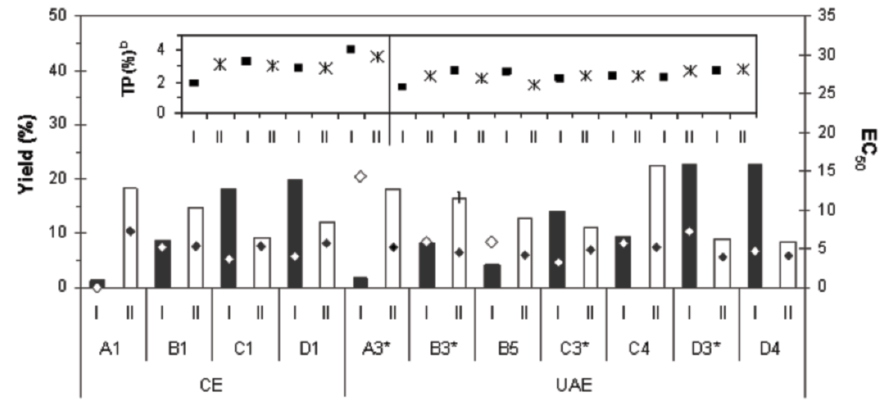
Figure 5. Effect of sonication on the yield and properties of ws-polysaccharides of wheat bran. Conditions: liquid/solid ratio 10 mL g-1, 40°C. , antioxidant activity in the DPPH• test. Yield (columns); EC (points inserted in columns), antioxidant TP, total phenolics content; EC 50 50 activity in the DPPH test expressed as mg sample/mg DPPH•. Conditions: solvent (A) water, (B) 0.5% NaOH, (C) 2% NaOH, and (D) 5% NaOH; letters without asterisk, extraction in step I was prolonged after sonication to 60 min; letters with asterisk indicate extraction without prolongation; liquid/solid ratio 10 mL g -1 , 40°C. TP, total phenolics